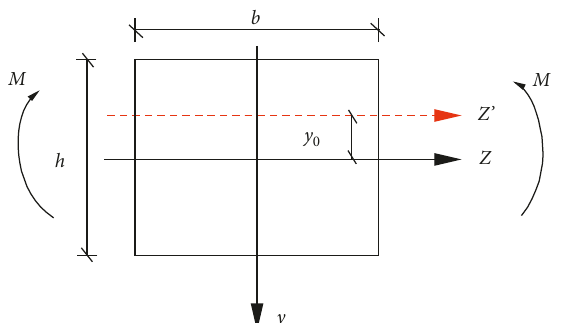
Figure 1: A schematic diagram of the bending force of the cross section of the